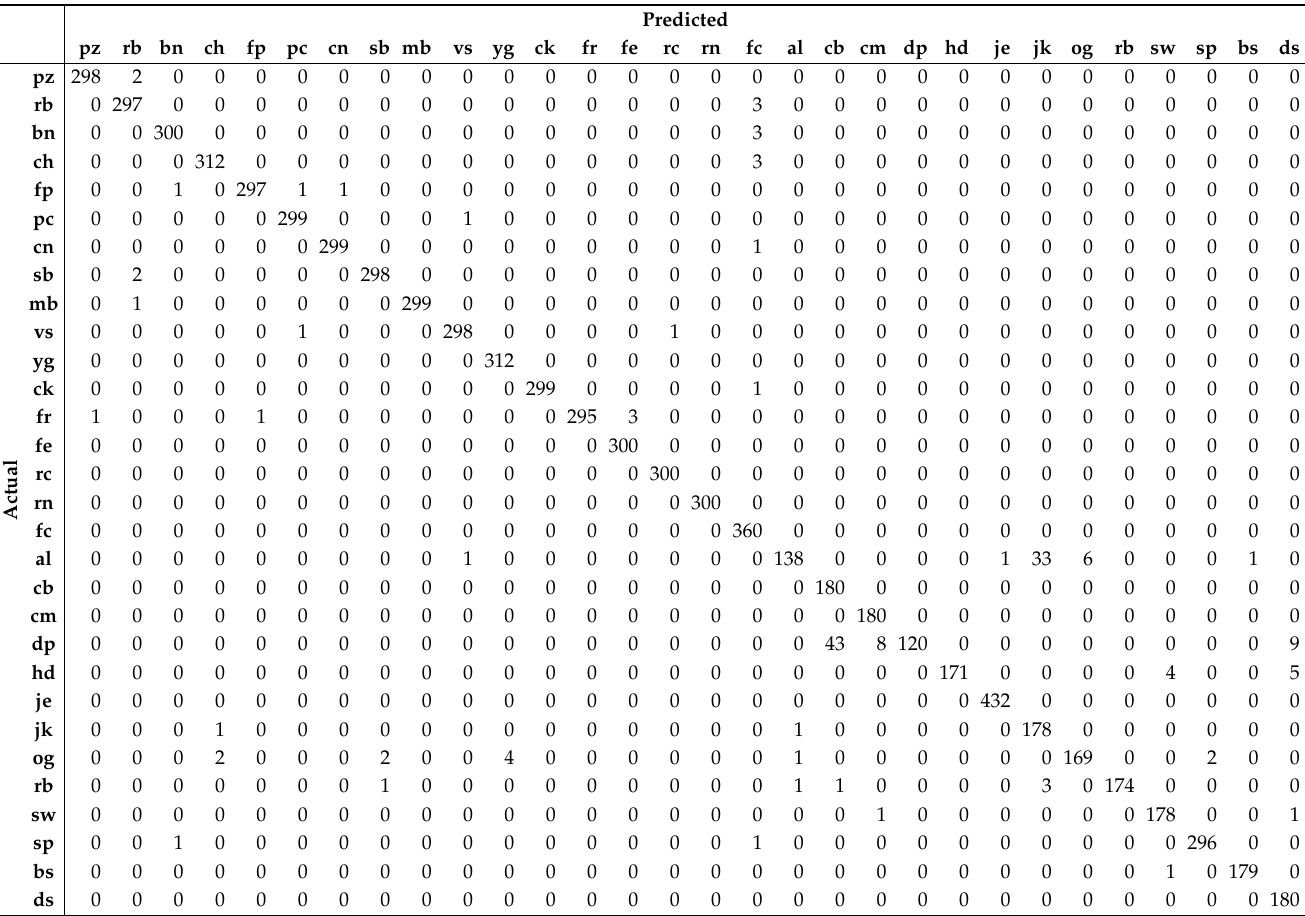
Table 3. The confusion matrix for 30 food items and 7894 food images. (pz:pizza, rb:rye bread, bn:banana, ch:milk chocolate, fp:fried potato, pc:potato chips, cn:cashew nuts, sb:strawberry, mb:mochabread, vs:vegetable salad, yg:yogurt, ck:chicken breast, fr:fried rice, fe:fried egg, rc:rice cake, rn:ramen noodle, fc:fried chicken, al:almond, cb:chocolate bar, cm:cereal with milk, dp:dumpling, hd:hotdog, je:jelly, jk:jerky, og:orange, rb:red-bean porridge, sw:sandwiches, sp:spaghetti, bs:beefsteak, ds:dried sweet potato).